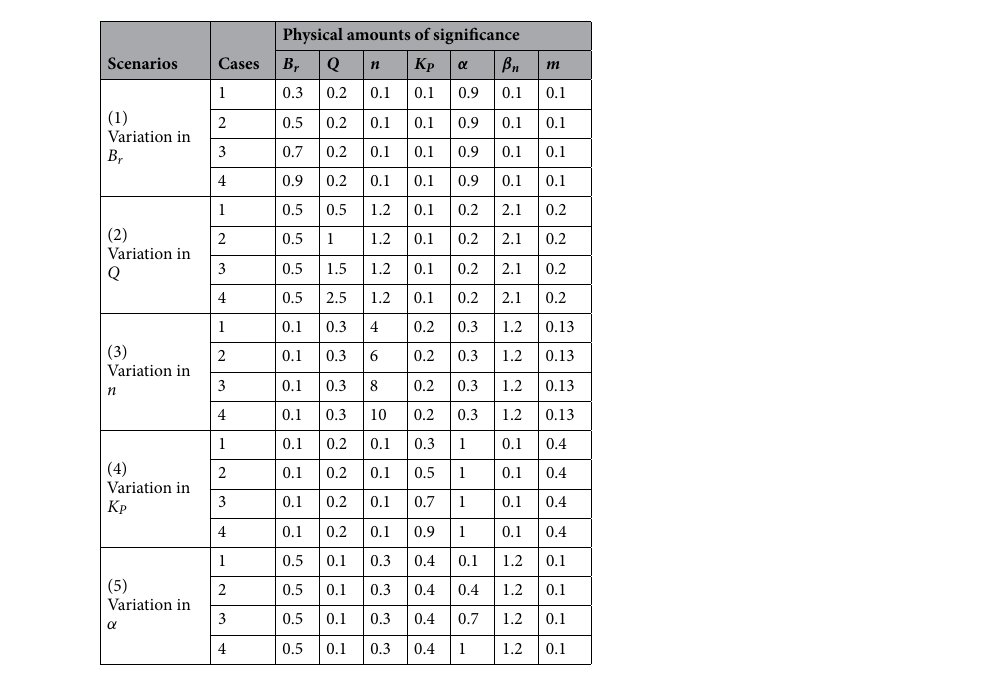
Table 3. Variants of WCS-EPF for Reynolds